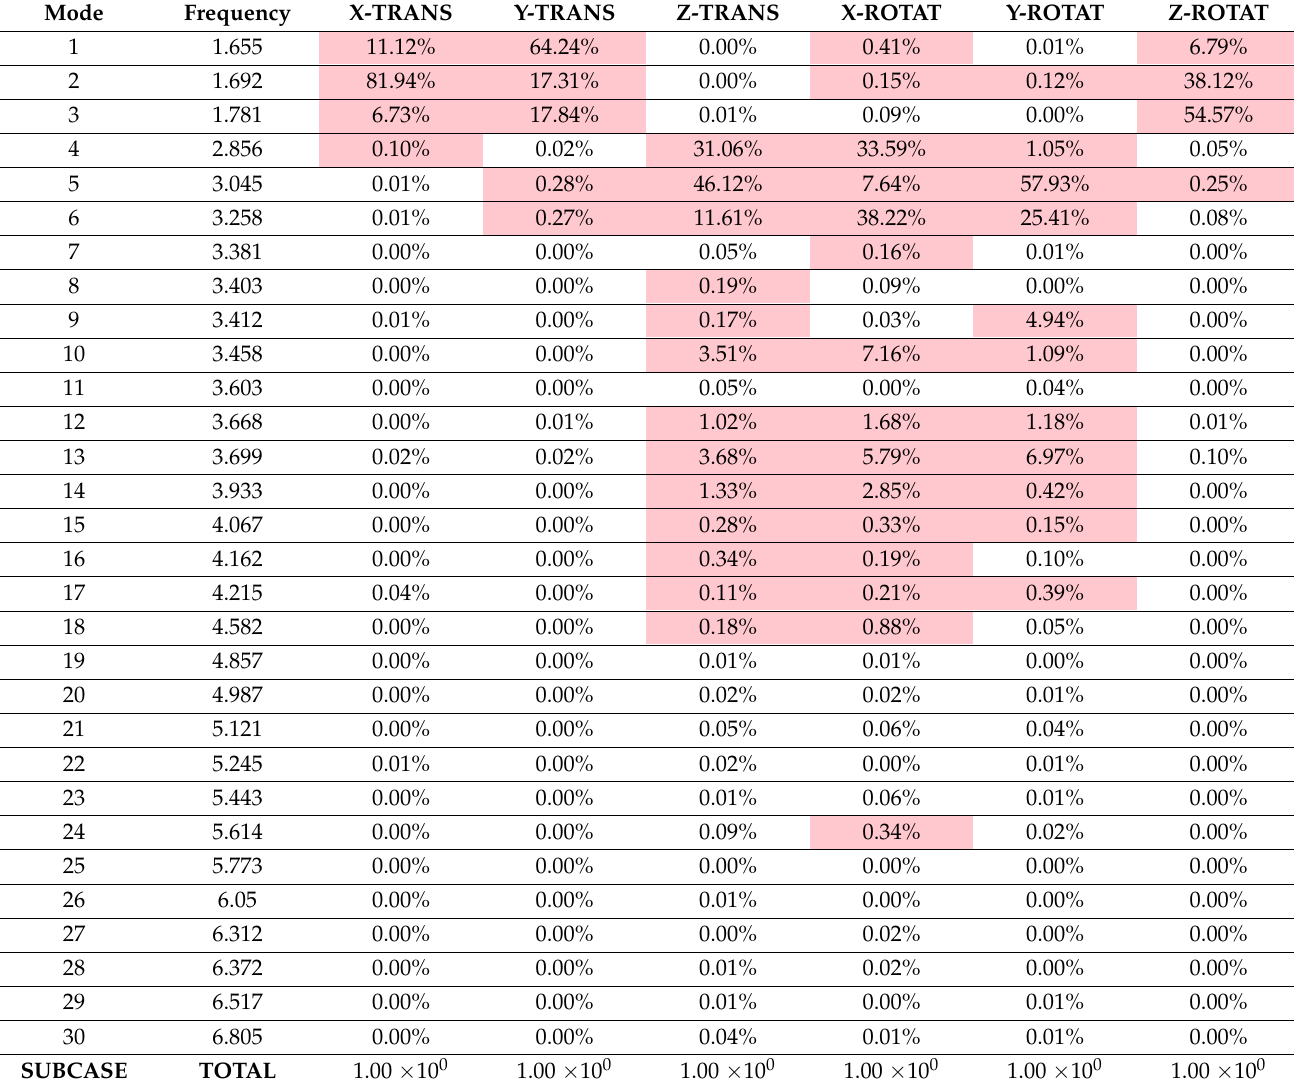
Table A2. The normalized factors of modal participationare (the values greater than 10% were marked with